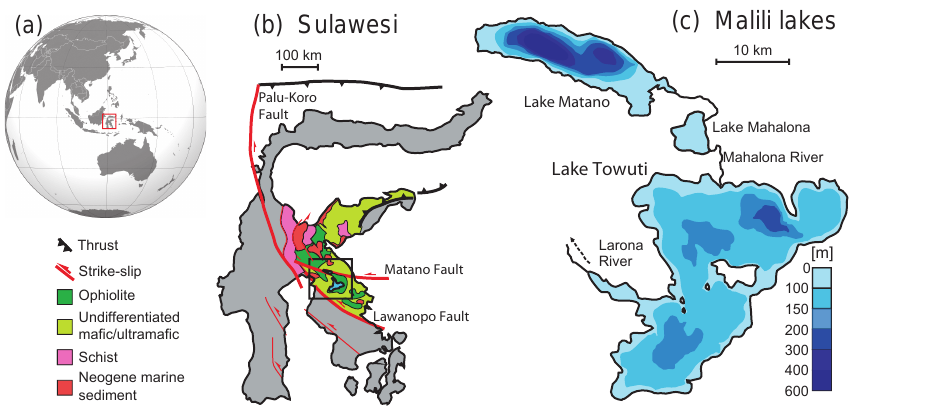
Figure 1. Overview map of the study area showing (a) the location of Sulawesi in the Indo-Pacific region, (b) the regional geology of Sulawesi (modified after Kadarusman et al., 2004), and (c) the configuration of the Malili lake